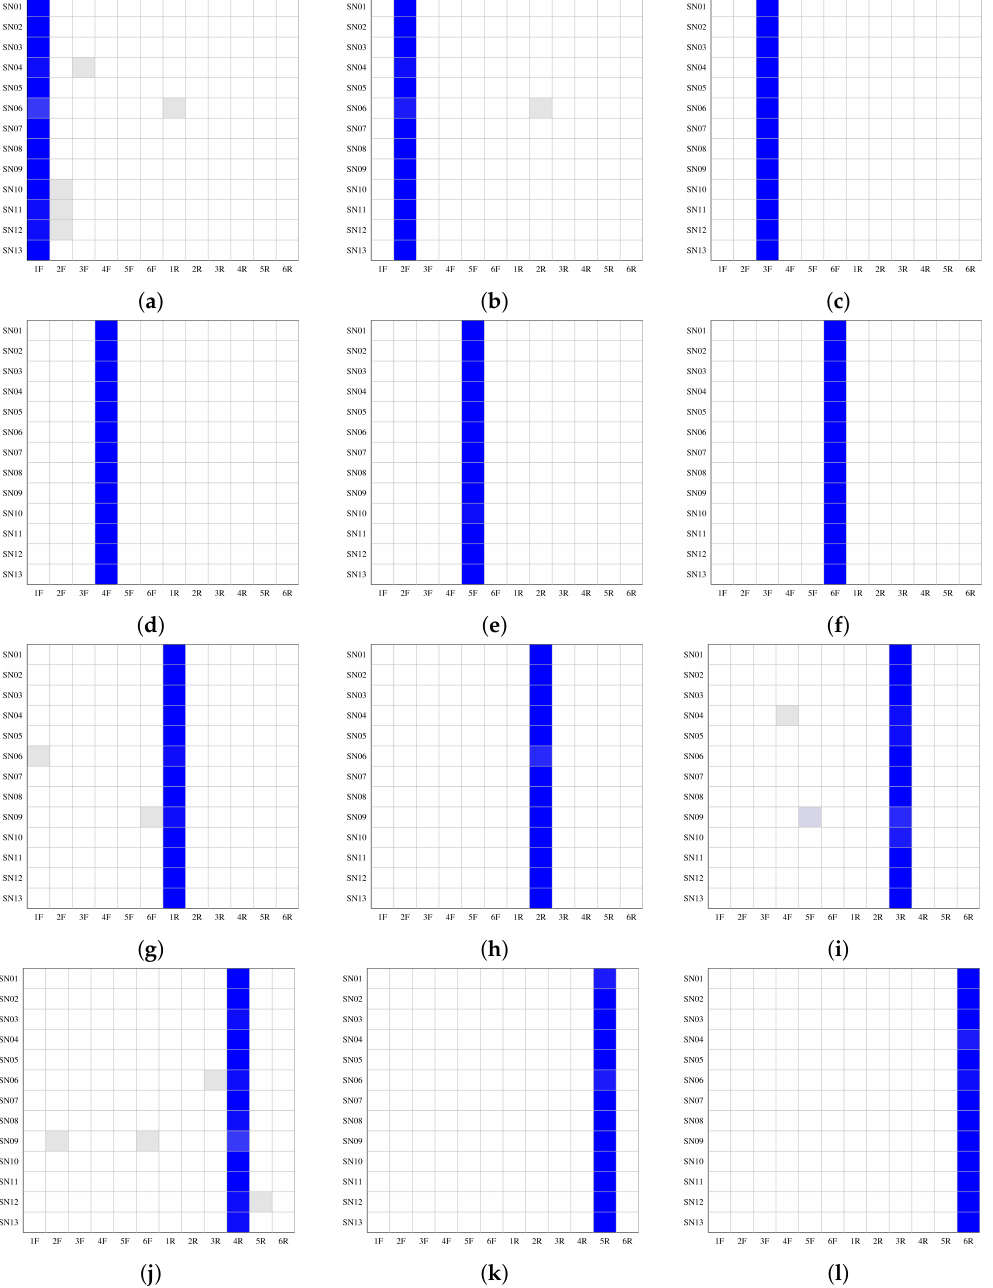
Figure 5. Profile attribution results: each graph groups the results of a single source on all thirteen SNs, six for the front cameras ( a – f ) and six for the rear cameras ( g – l ); the number of images in each cell is identified through a white-to-blue scale, from 0 (white) to 17